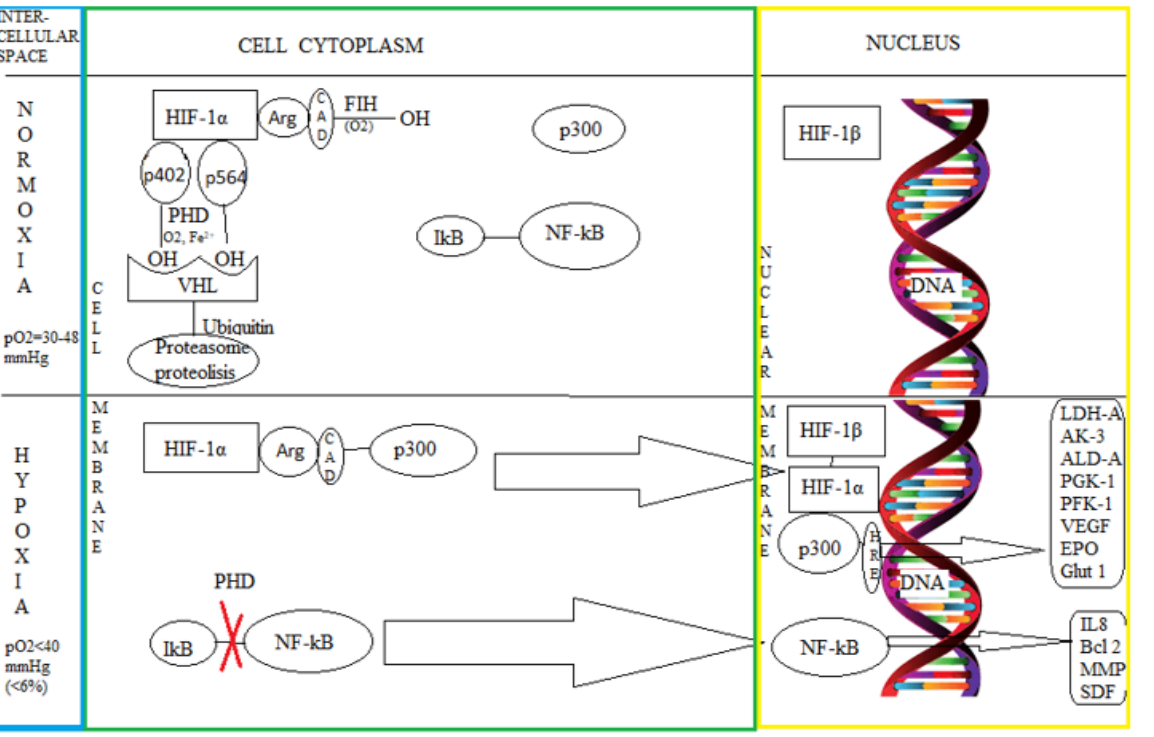
Figure 2. The cellular mechanism of hypoxia (showing how oxygen partial pressure, pO2, in- fluences deoxynucleic acid, DNA, via hypoxia-inducible factor, HIF; with involvement of factor inhibiting HIF, FIH; arginine, ARG; C-terminal transactivation domain, CAD; protein 300, p300 and Von Hipple-Lindau factor, VHL and proline hydroxylase, PHD. We can see how hypoxia response elements (HRE) are activated, as the atypical Nuclear Factor kB, NF-kB, activation pathway, with involvement of inhibitor kB, I-kb. This triggers the genes of lactate dehydrogenase A, LDH-A; adenylate kinase 3, AK-3; aldolase A, ALD-A; phosphoglycerate kinase 1, PGK-1; phosphofructoki- nase, liver type, PFK-L 6; vascular endothelial growth factor, VEGF; erythropoietin, EPO; glucose transporter 1, Glut-1; interleukin 8, IL 8; B cell lymphoma-2, Bcl-2; matrix metalloproteases, MMP; stromal cell-derived factor 1,